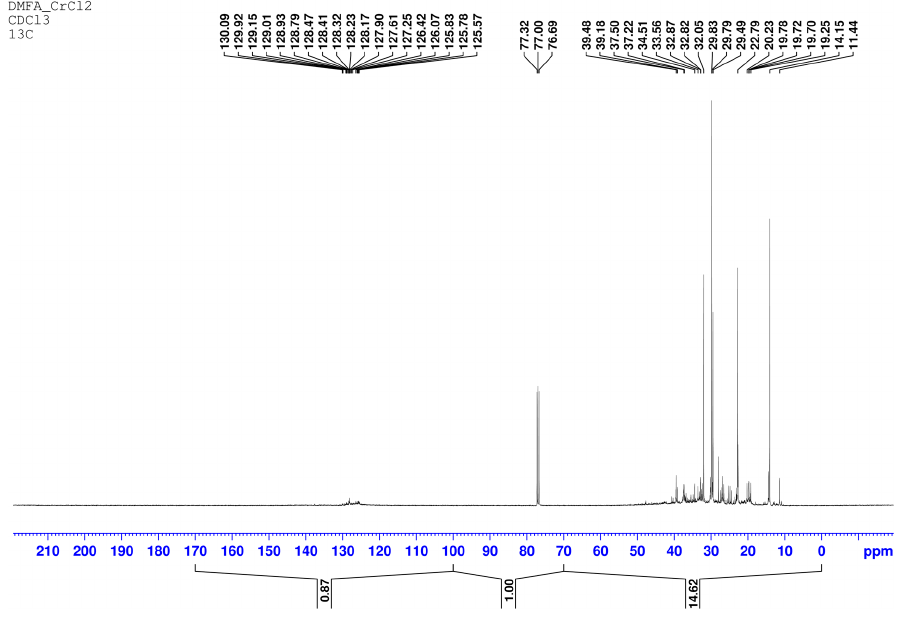
Figure 3. 13 С NMR spectra of the desulfurized diesel fraction 200–350 ° С . Figure 3. 13 C NMR spectra of the desulfurized diesel fraction 200–350 ◦